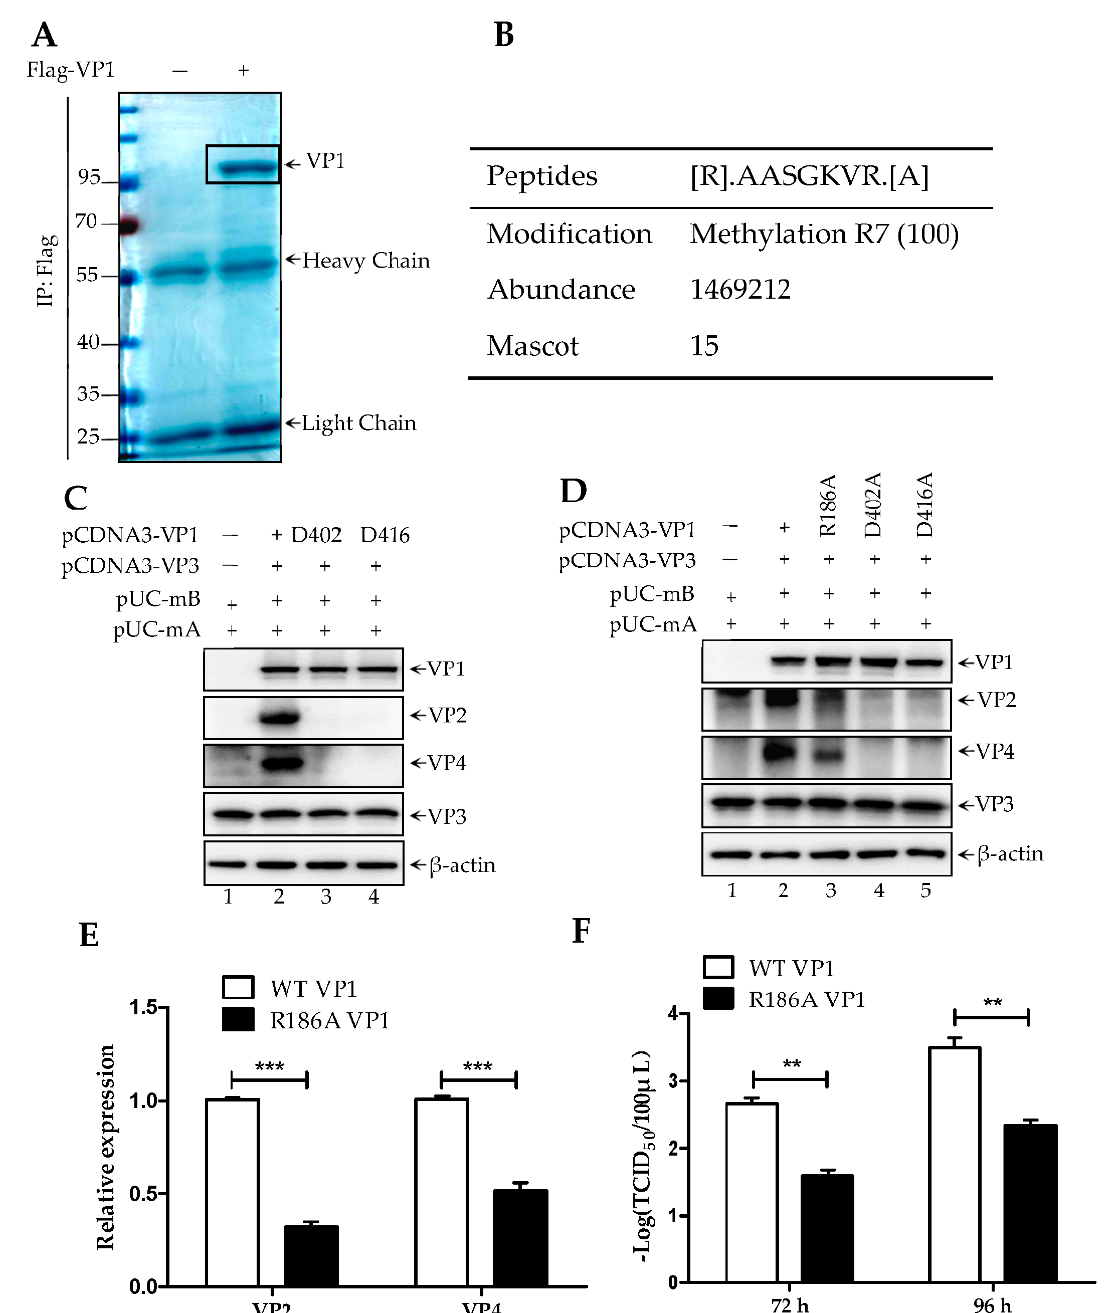
Figure 4. Arg 186 monomer-methylation facilitates VP1 activity. ( A ) 293T cells was transfected with Flag-VP1 (non-transfection as negative control) for 48 h. Whole cell lysates were subjected to immunoprecipitation by using anti-Flag agarose. Purified Flag-VP1 was separate by SDS-PAGE and visualized via Coomassie brilliant blue staining. Specific band of Flag-VP1 was cut for LC–MS. The Arg186 was identified as a monomer-methylation site of which the peptide was shown in the right box ( B ). ( C ) Indicated plasmids were transfected into 293T cells for 72 h, which were furtherly examined by western blotting, using indicated antibodies. ( D ) Indicated plasmids were transfected into 293T cells for 72 h, which were furtherly examined by western blotting, using indicated antibodies. β -actin was used as the loading control. ( E ) The data of band density shown in ( D ) was presented as means ± SD with three independent experiments, *** p < 0.001. ( D ) Indicated plasmids were transfected into 293T cells for 72 h and 96 h. The supernatant of indicated transfected cells were subjected to analyze the virus titers using a TCID 50 assay. The data of virus titers was presented as means ± SD with three independent experiments, ** p < 0.01.